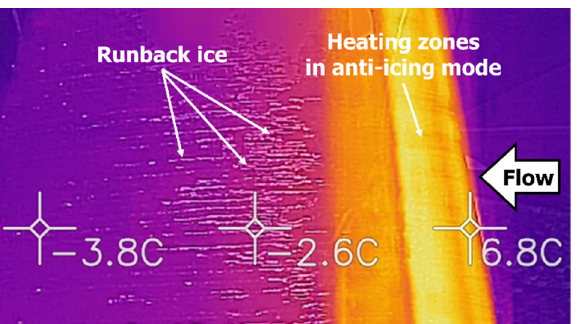
Figure 7. Thermal image of an anti-icing test. The leading-edge is continuously heated, producing runback water that refreezes downstream.